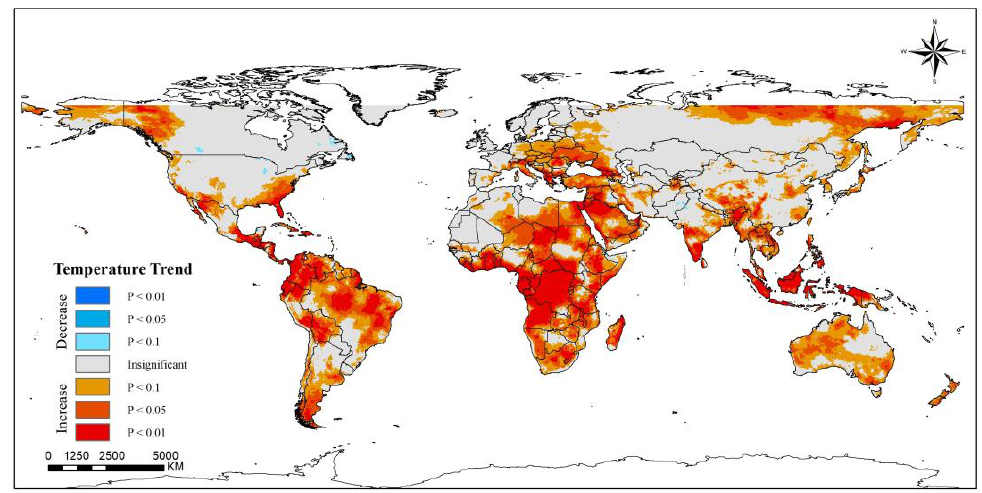
Figure 7. Spatiotemporal trends of temperature at 2 m high worldwide (2000 – 2019).